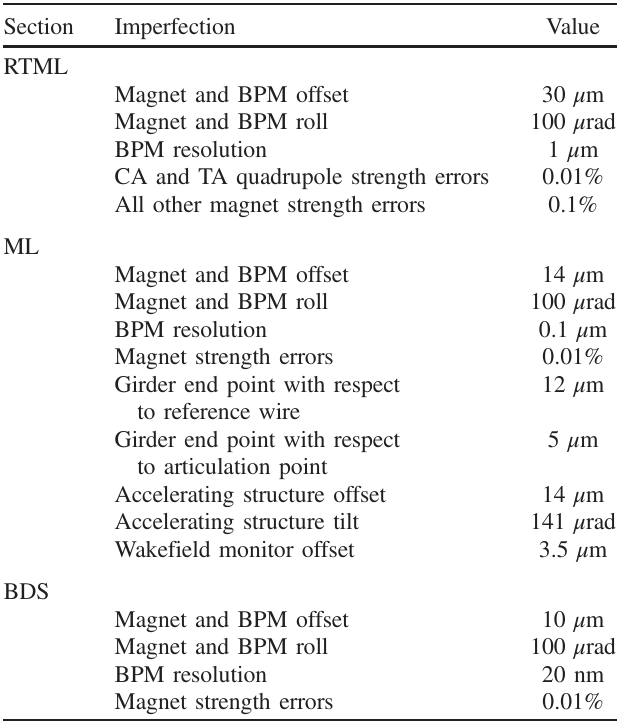
TABLE III. RMS values for static imperfections implemented in integrated simulations. CA is the central arc and TA is the turn around (see Fig.